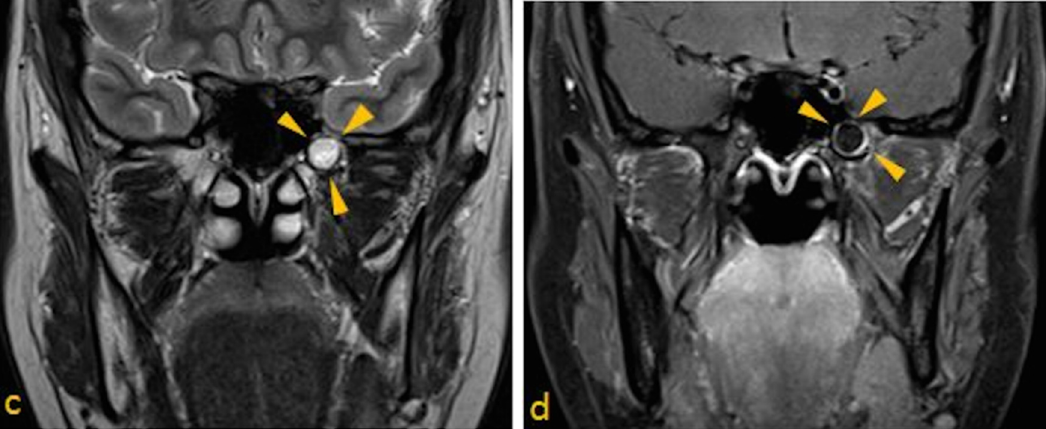
Figure 2. MRI features of arrested pneumatization of sphenoid sinus. ( a ) T1 paracoronal pre-contrast image; ( b ) T1 paracoronal post contrast image; ( c ) T2 paracoronal post gadolinium images, show hyperintense lesion in the left pterygoid process without enhancement; and ( d ) T1 paracoronal post-FS, shows homogeneous loss of signal, consistent with